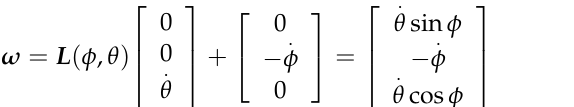
and represent the absolute derivative of V in inertial coordinate system, and the relative derivative of V in LOS coordinate sys- a represent the accelerations of the target and missile, re- a and tem, respectively; T M spectively; and ω represents the relative rotation angular velocity of LOS coordinate sys-